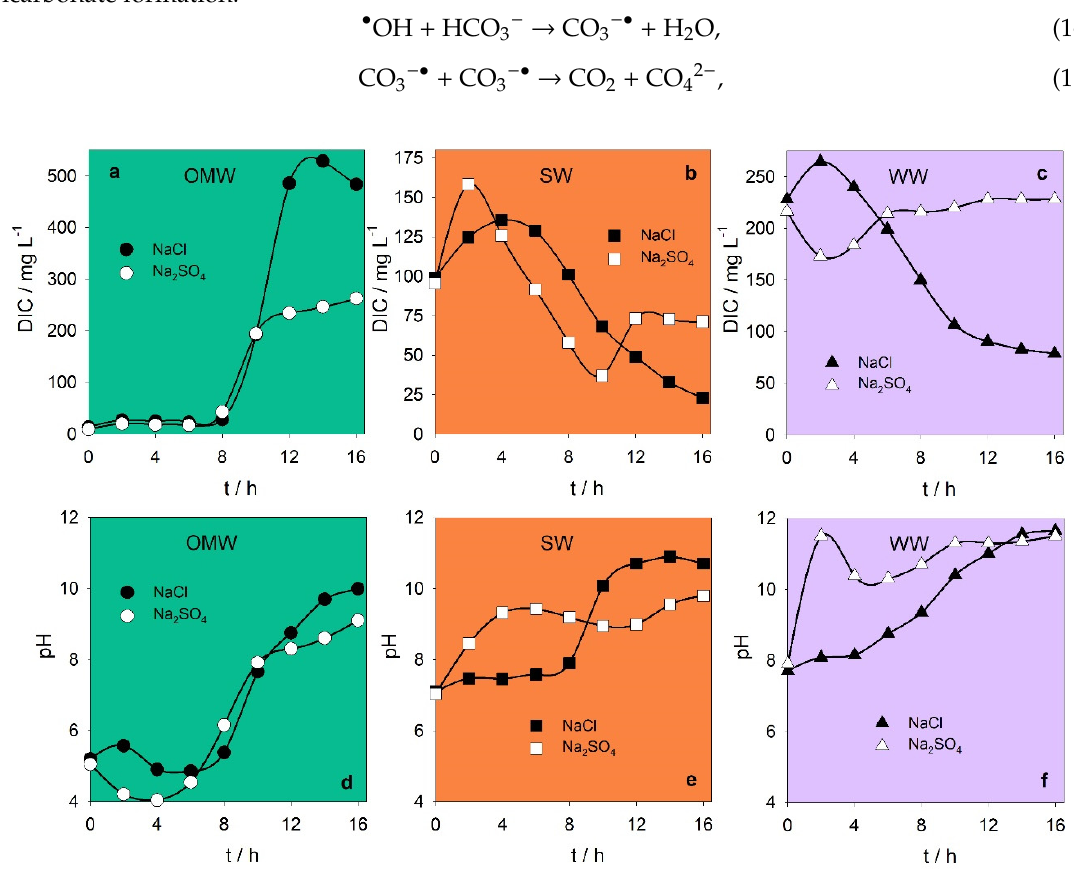
Figure 2. DIC variation in time during the electrooxidation treatment of ( a ) Olive mill wastewater (OMW), ( b ) Slaughterhouse wastewater (SW), and ( c ) Winery wastewater (WW), utilizing NaCl or Na 2 SO 4 as supporting electrolyte. pH variation for the same experiments with ( d ) OMW, ( e ) SW, and ( f )